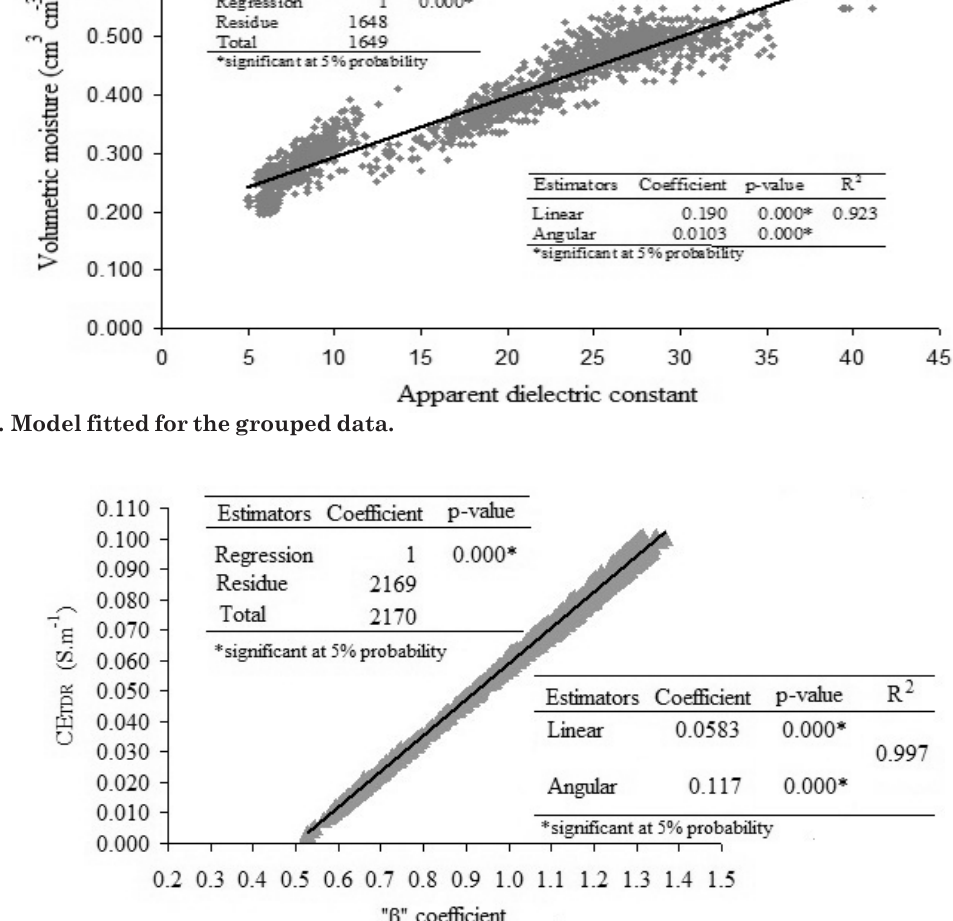
Figure 5. Linear correlation between the â coefficient and EC